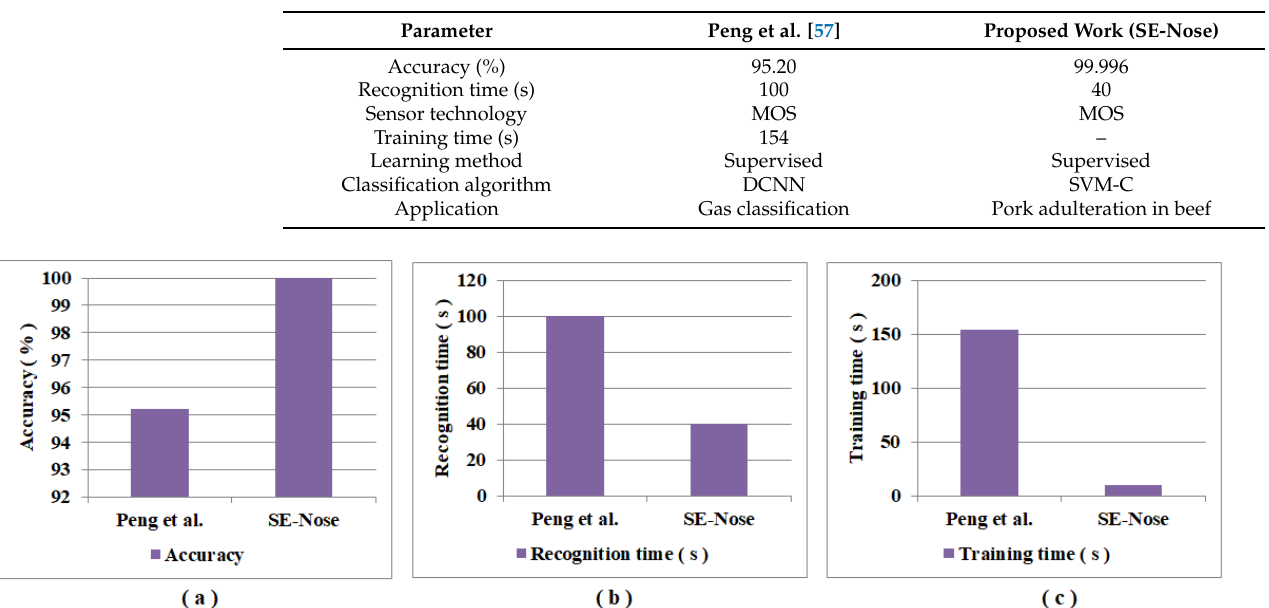
Figure 5. Graphical representation of a comparison of performance metrics: ( a ) accuracy; ( b ) recogni- tion time; ( c ) size of the input data of R. Sarno et al. [42] and the SE-Nose methodology. Table 10. Comparison of results obtained by SE-Nose methodology with Peng et al. [57].